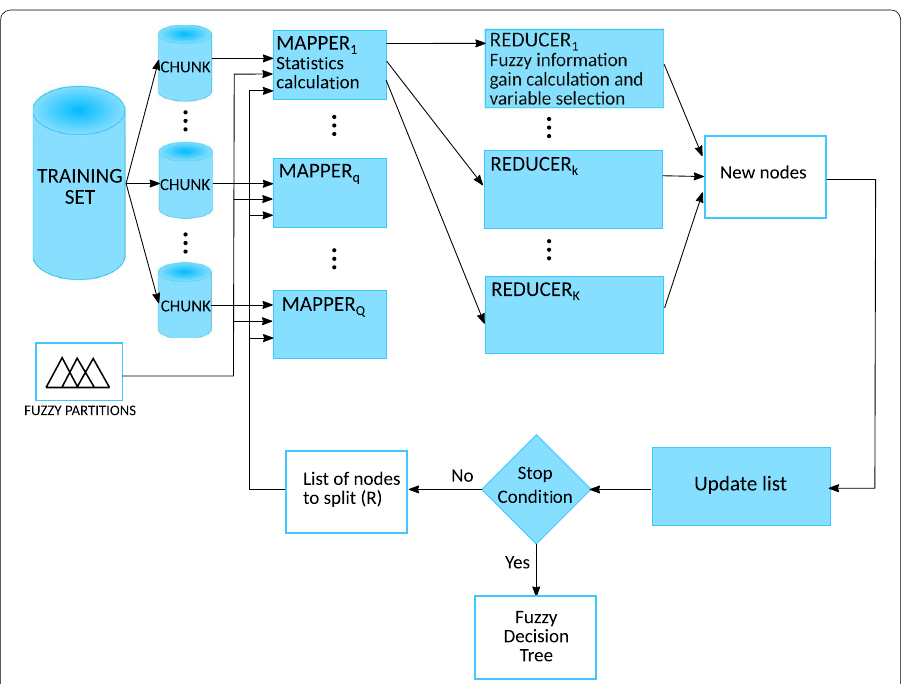
Fig. 10 MapReduce scheme of the distributed FDT learning